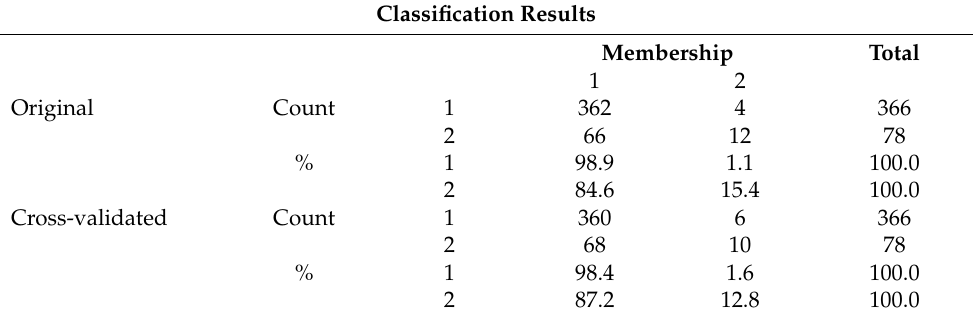
Table 8. Classification ability of